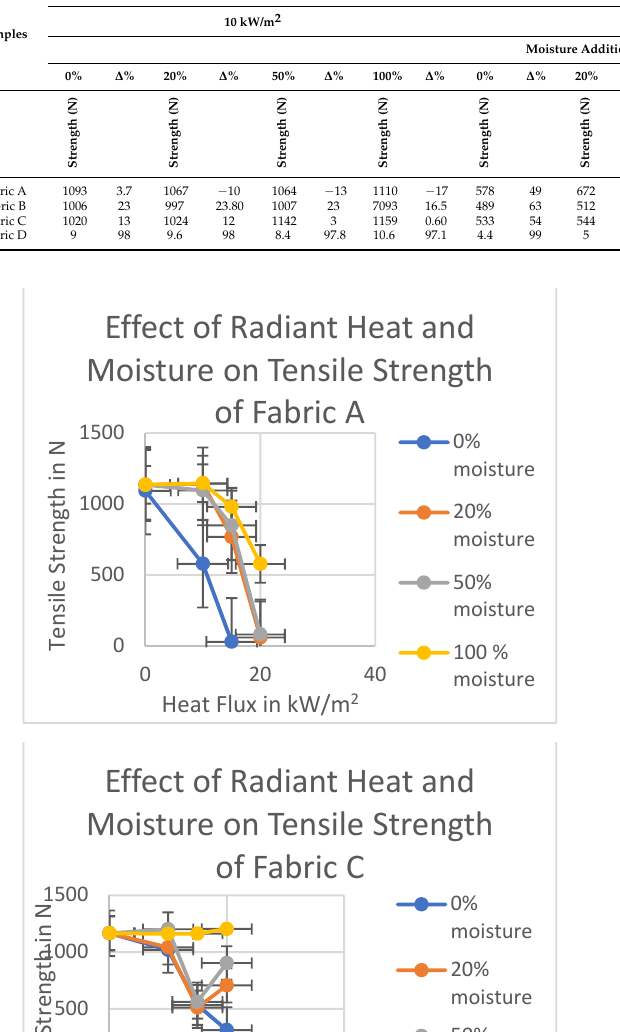
was negative for 20% and 100% moisture addition. The strength loss was also significantly lower at 15 kW/m 2 and 20 kW/m 2 with the presence of moisture compared to the dry fab- rics. With the increased moisture, the strength loss percentage decreased. The strength losses were 32%, 25%, and 14%, respectively, for 20%, 50%, and 100% moisture addition Table 6. Effect of moisture and radiant heat on tensile strength of outer layer fabrics (Single layer). at 15 kW/m 2 . However, at the highest radiant flux at 20 kW/m 2 the strength loss percent- ages were 95% and 93% for 20% and 50% moisture addition. At higher heat flux, lower HeatFlux moisture content (20% and 50%) did not affect the tensile strength significantly. However, 10kW/m2 15kW/m2 20kW/m2 Samples at 100% moisture addition the heat loss percentage was only 49% which is half compared MoistureAdditionandTensileStrengthLoss% to 98% at the dry condition at 20 kW/m 2 . The 20% and 50% moisture addition had a very minor effect on the tensile strength at 15 and 20 kW/m 2 in fabric B. The difference was below 10% at this moisture addition compared to the dry condition. However, the 100% moisture addition showed a significant effect even at higher heat flux. The tensile strength loss was 12% and 54% at 15 and 20 kW/m 2 , respectively, which were 63% and 79% for the same fabric in dry condition.